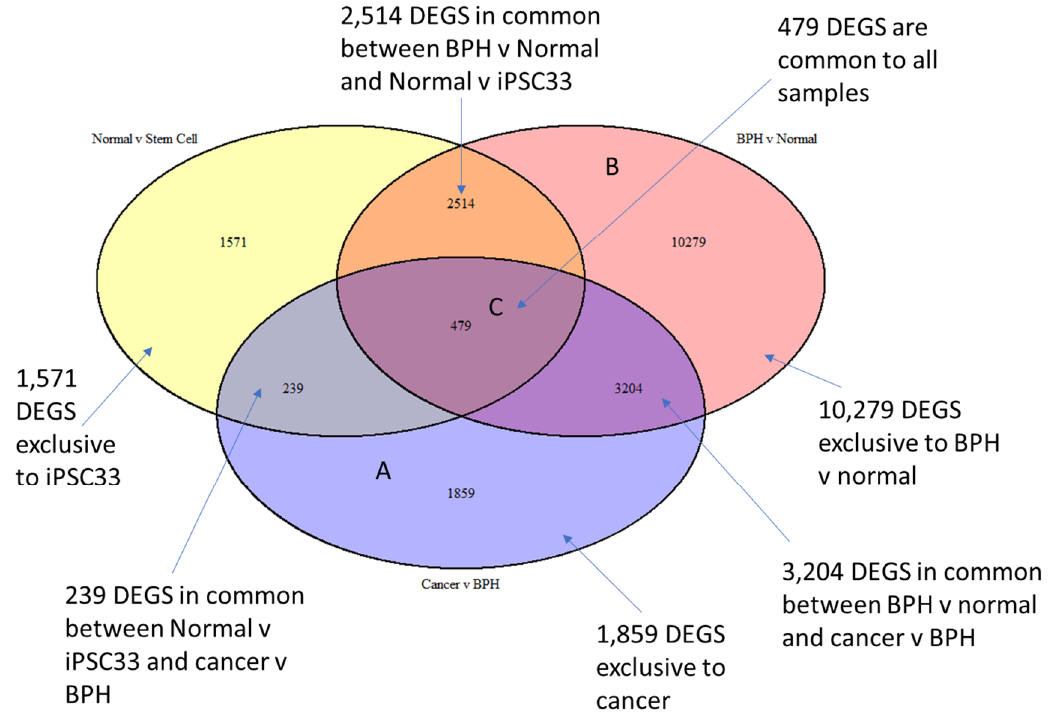
Figure 3. Gene signatures common in embryonic, cancer, and BPH datasets. ( A ) Exclusive to cancer; ( B ) exclusive to BPH; ( C ) common to all; related to stem cells reawakening and cancer or BPH.